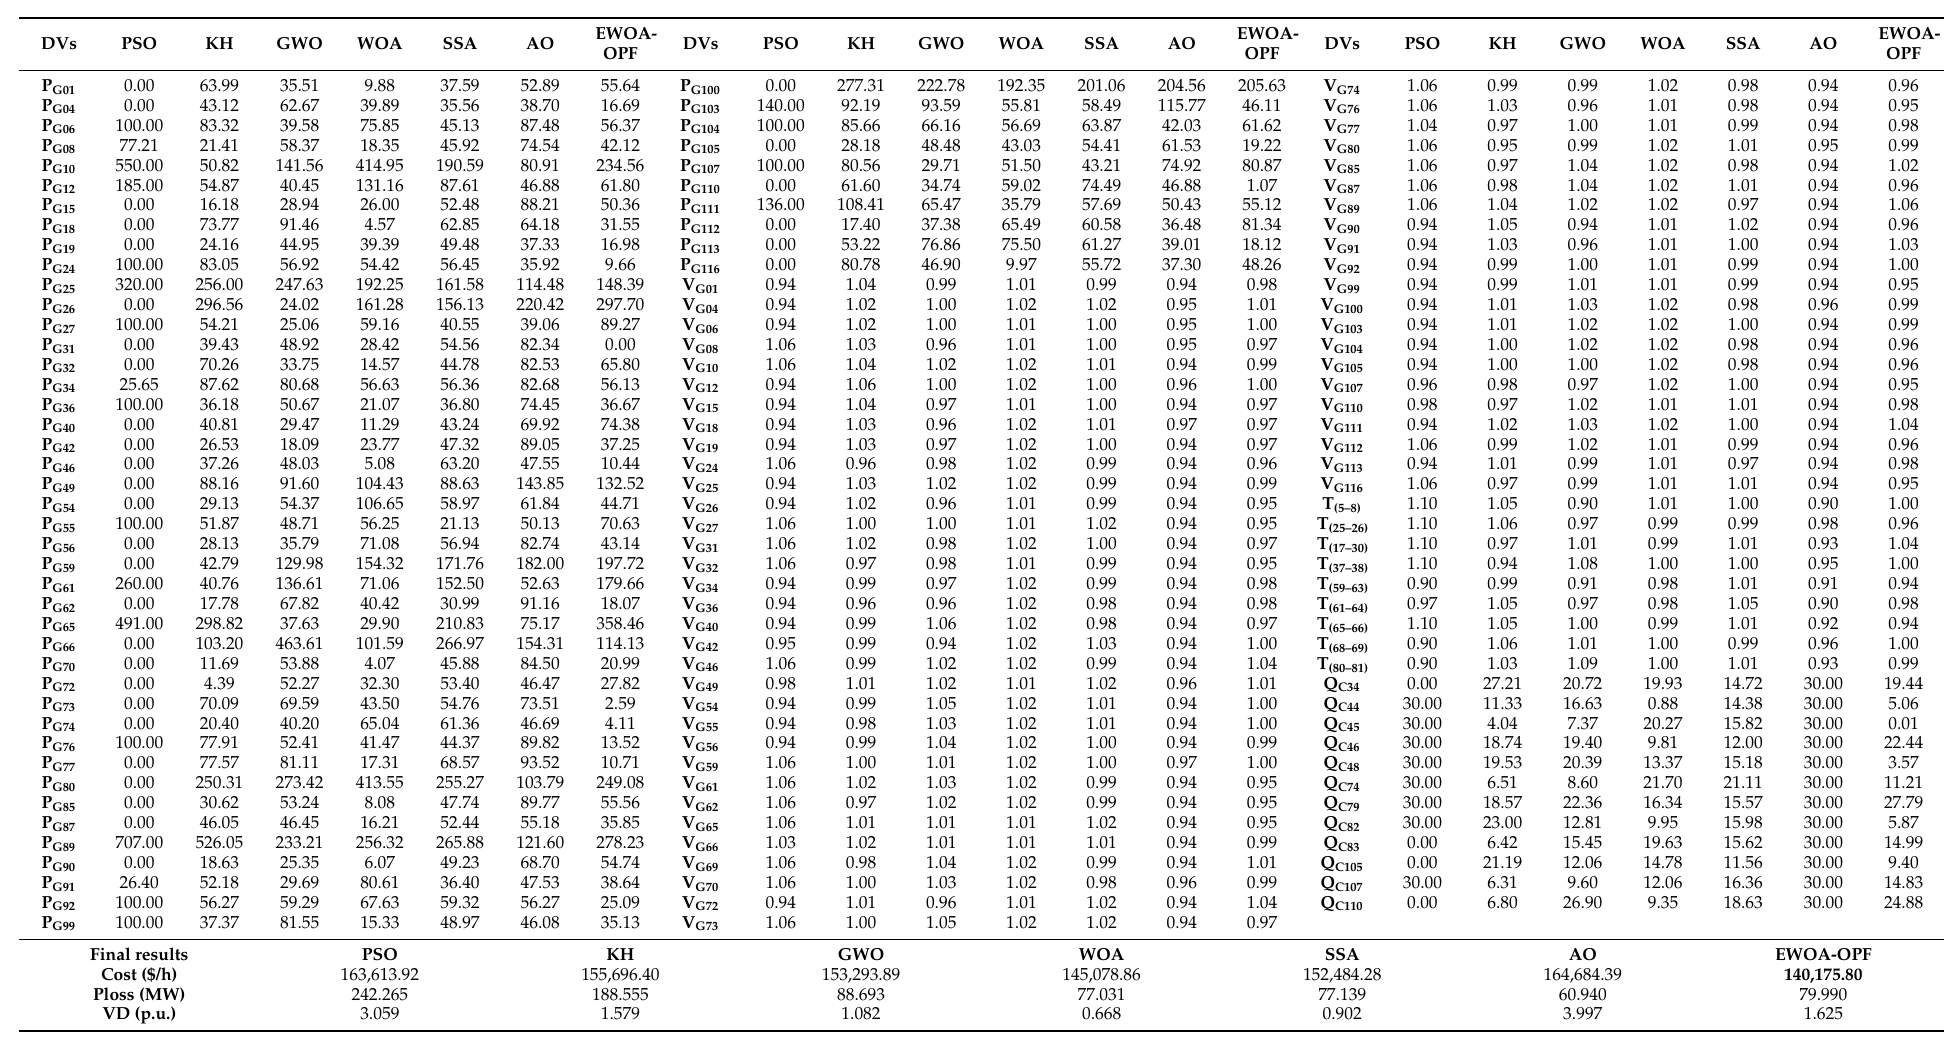
Table A2. Results of OPF for IEEE 118-bus test system on Case